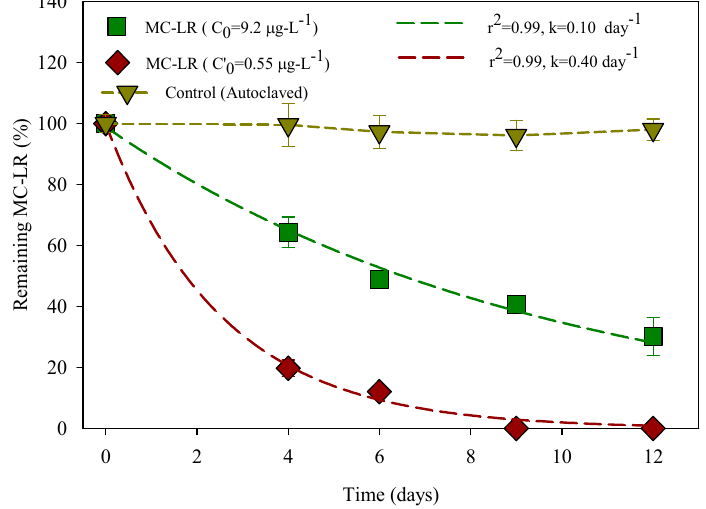
Figure 2. Change in MC ‐ LR concentrations in Hulupi Lake water samples at 25 °C. The curves are modeled to fit the first ‐ order reaction model. The error bars represent one standard deviation for three measurements.